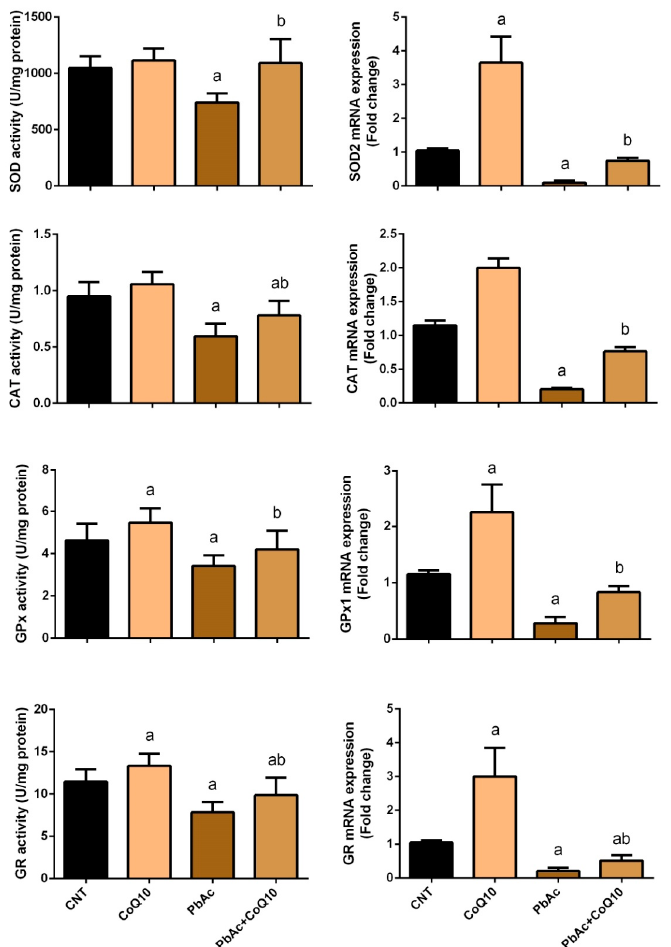
Figure 3. Effects of coenzyme Q10 on cortical SOD, CAT, GPx, and GR activity and their mRNA expression following lead acetate exposure. Results represent the mean ± SD ( n = 7); significant changes at P < 0.05 were determined using Duncan’s post-hoc test. a significant changes compared with the control group; b significant changes compared with the PbAc injected group. mRNA expression data are expressed as the mean ± SD of triplicate assays normalized to β -actin and expressed as fold changes (log2 scale) compared with the mRNA levels of the control group.